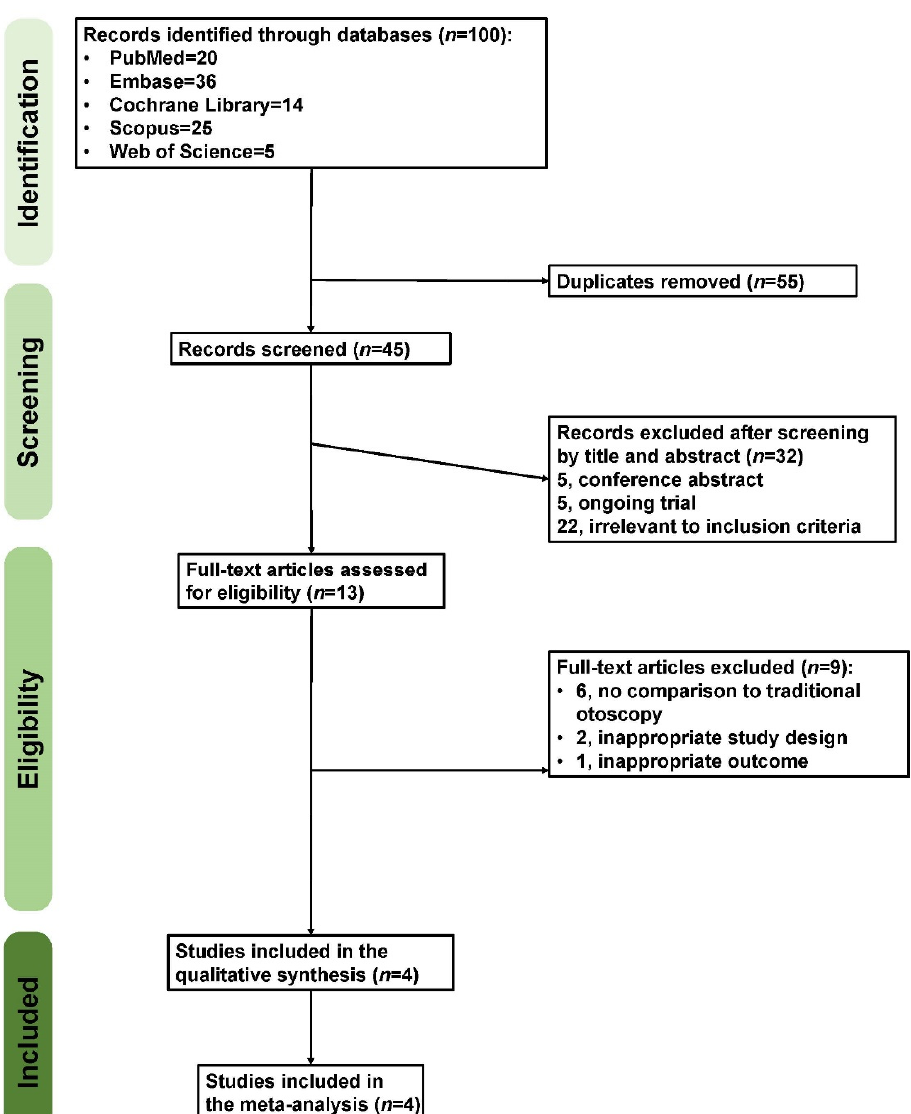
Figure 2. The Preferred Reporting Items for Systematic Reviews and Meta-Analyses (PRISMA) flow diagram.